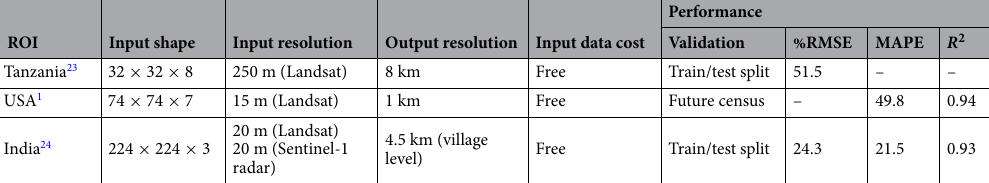
Table 2. Summary of recent literature on deep learning driven census-dependent intercensal population estimation. NOTE: Input Resolution indicates the spatial resolution of imagery input to model (i.e. after reprojection and resizing). %RMSE is percent root mean squared error, MAPE is mean absolute percent